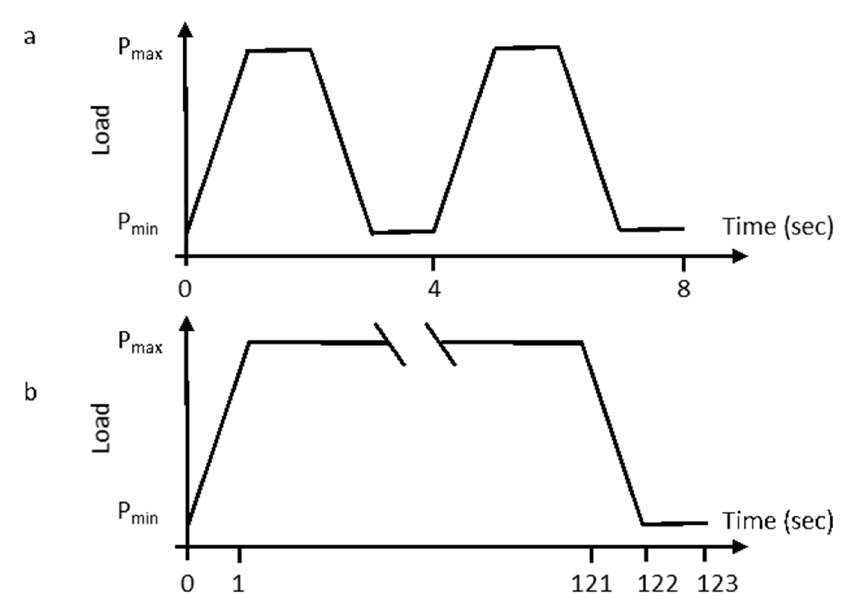
Figure 5. Schematic representation of ( a ) cyclic and ( b ) dwell load controlled fatigue